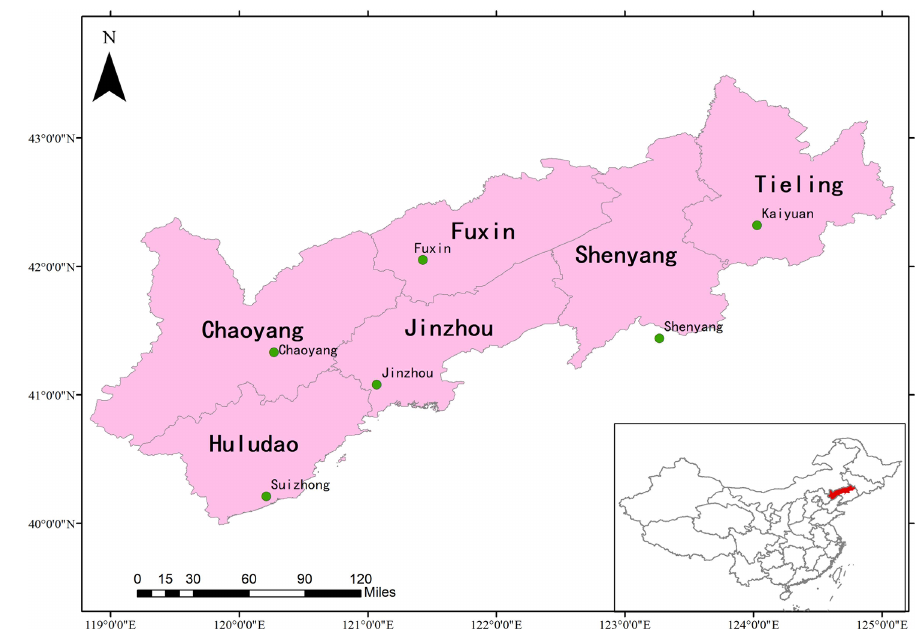
Figure 1. Study area and the location of the selected meteorological stations.